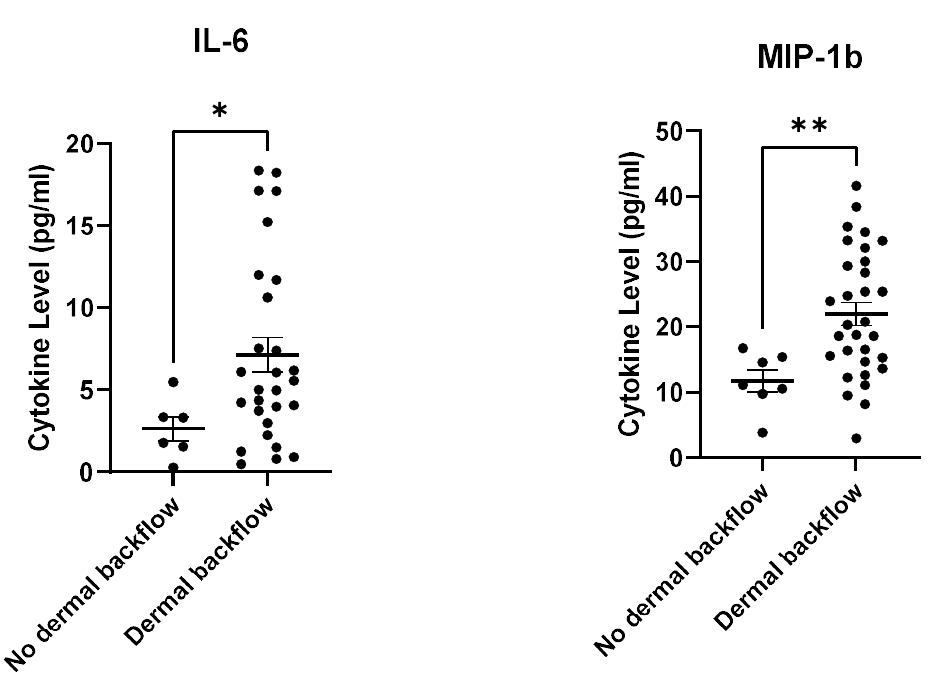
Figure 4. Plasmas IL-15, IL-3, and MIP-1β levels at 12-months post-RT were significantly elevated